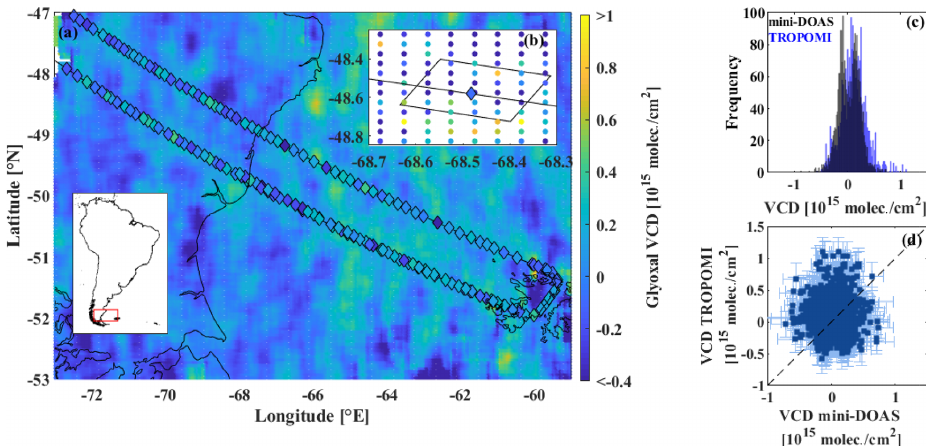
Figure 8. Glyoxal measurements in the pristine marine atmosphere over the South Atlantic between southern Patagonia (Argentina) and the surrounding islands on 9 November 2019. (a) Along-track mini-DOAS glyoxal measurements (diamonds with black contours) with the collocated same-day L3 TROPOMI observations at 0.25 ◦ × 0.25 ◦ resolution. For better visibility, only every fifth mini-DOAS measurement is shown. (b) Spatial gridding of 25 high-resolution TROPOMI measurements around an individual mini-DOAS observation. (c, d) Frequency distribution and scatterplot of the inferred glyoxal VCDs from the mini-DOAS instrument versus TROPOMI L3 averaged on 0.25 ◦ × 0.25 ◦ , according to panel (b)